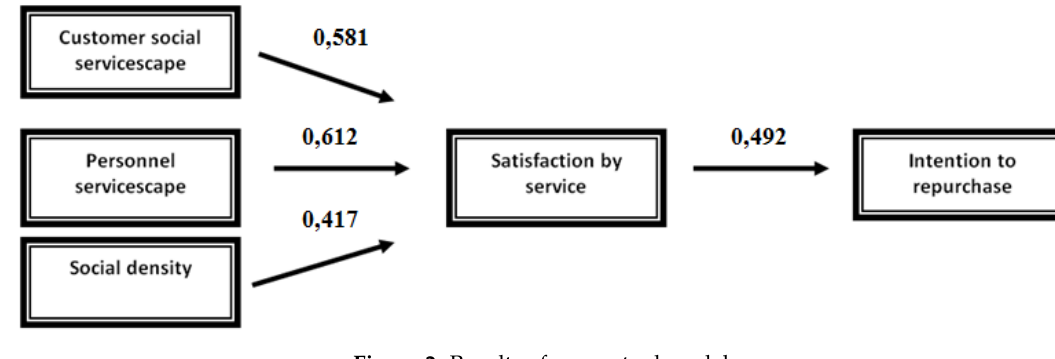
Figure 2. Results of conceptual model.